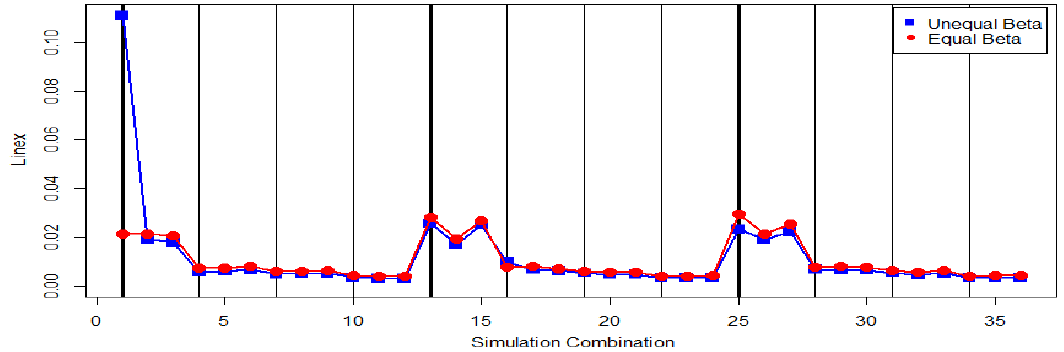
Figure 10. The values of EAE ( ˆ δ Linex ) for the cases of β 1 = β 2 and β 1 (cid:54) = β 2 . 4.5. Comparison between Expected Square Error on ˆ δ SE and ˆ δ Linex and Expected Absolute Error on ˆ δ AE